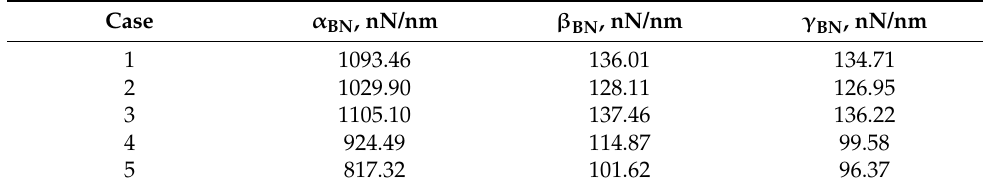
Table 6. The mean difference between the SWBNNTs rigidities values estimated with Equations (26)–(28) and the respective values obtained from FE analysis. Table 5. The fitting parameters α BN , β BN and γ BN for SWBNNTs, considering the five cases of input values shown in Table